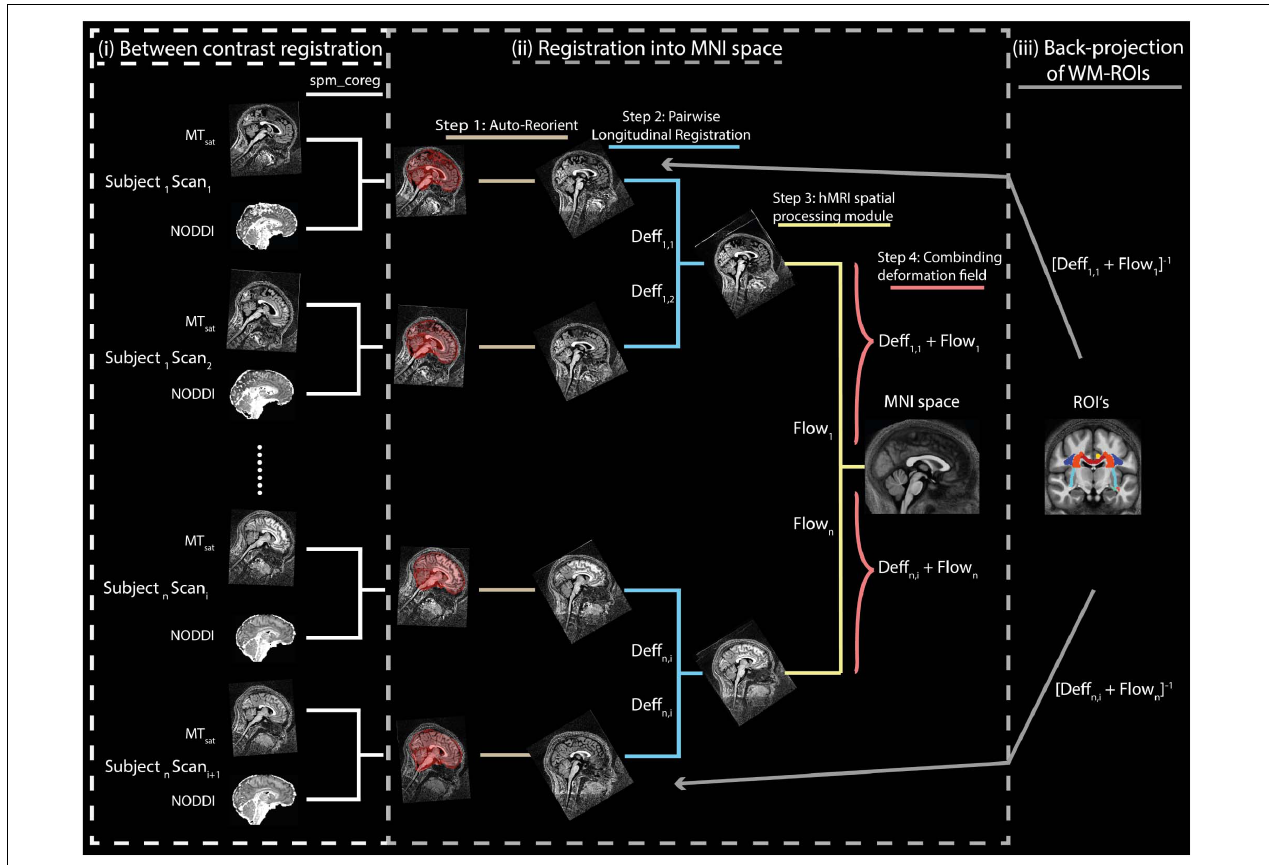
FIGURE 1 | Illustration of the spatial alignment pipeline of the MT sat and NODDI maps. The pipeline consists of (i) co-registration between MT sat and NODDI maps (driven by ODI map), (ii) normalization into MNI space, and (iii) back-projection of ROIs into the native space. Note that each subject consists of two sets of images acquired in separate sessions. In the co-registration step (section “Co-registration”), the white matter (WM) tissue probability map (TPM) of the ODI was co-registered to the WM TMP of the MT sat in each subject and session using rigid-body registration ( spm_coreg algorithm, SPM12). The resulting transformation was applied to all other NODDI maps as well. In the normalization step (section “Normalization”), MT sat maps were roughly aligned with the T1-weighted MNI template in each subject and session using the Auto-Reorient function. The realigned MT sat maps from both sessions were then registered to their mid-point average using the Pairwise Longitudinal Registration (SPM12). In each subject, the mid-point average MT sat map was normalized to the MNI space using the DARTEL-based (Ashburner, 2007) Spatial Processing module. Finally, all deformation fields were converted to a single deformation field and applied on the NODDI maps. In the last step (section “Region of Interest Selection”), the ROIs and the WM masks were back-projected into the native space using the inverse of the combined deformation